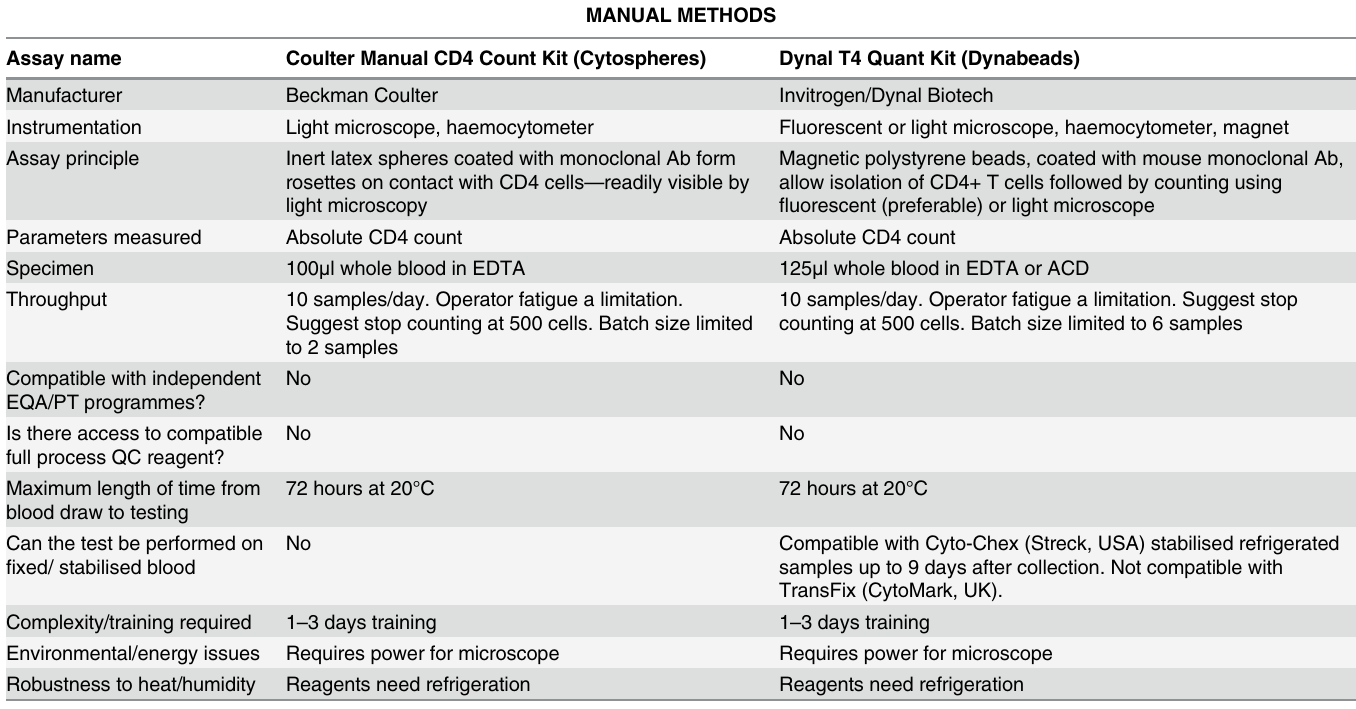
Table 3. Operating characteristics of manual technologies for CD4+ T-cell enumeration.